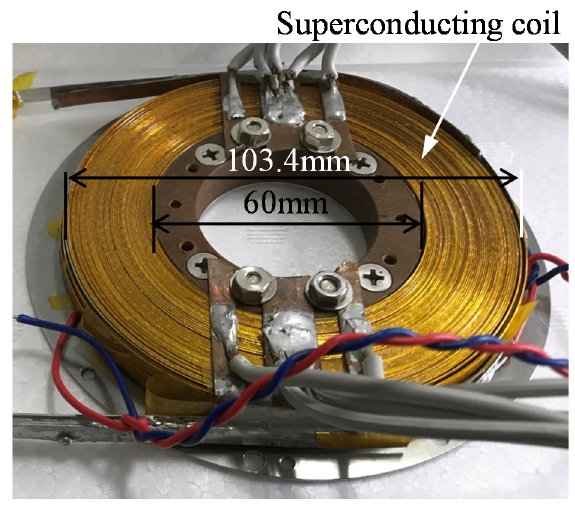
Figure 2. Photo of superconducting coil for persistent current.